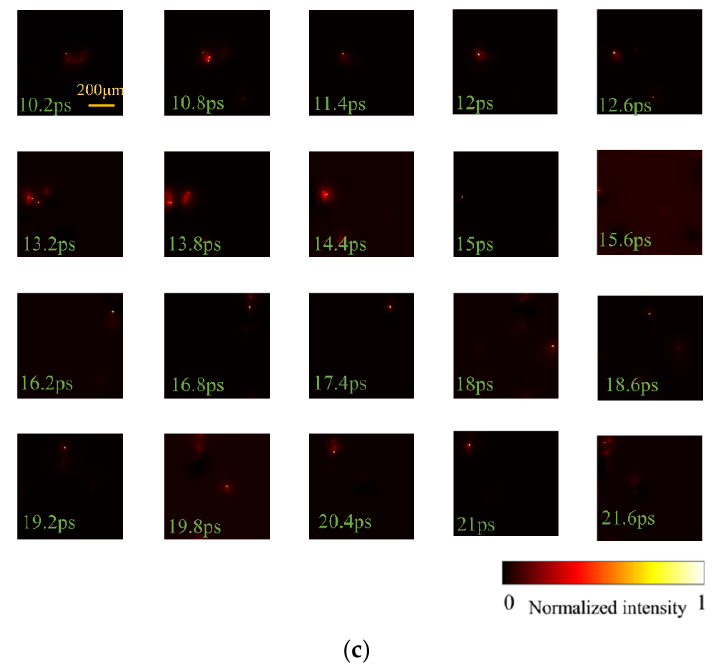
Figure 4. Representative frames of reconstruction results. ( a ) Reconstructed images (the volume ratio of photoresist: water = 1:3 volume ratio). ( b ) Reconstructed images (the volume ratio of photoresist: water = 1:1 volume ratio). ( c ) Reconstructed images photoresist (without water addition).